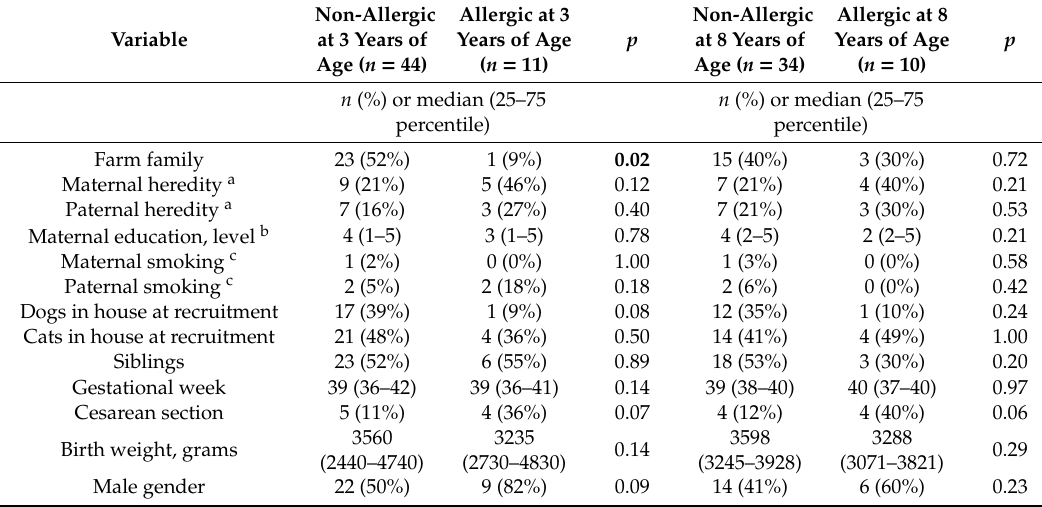
Table 4. Di ff erences in background characteristics between allergic and non-allergic infants in the FARMFLORA cohort. Variable